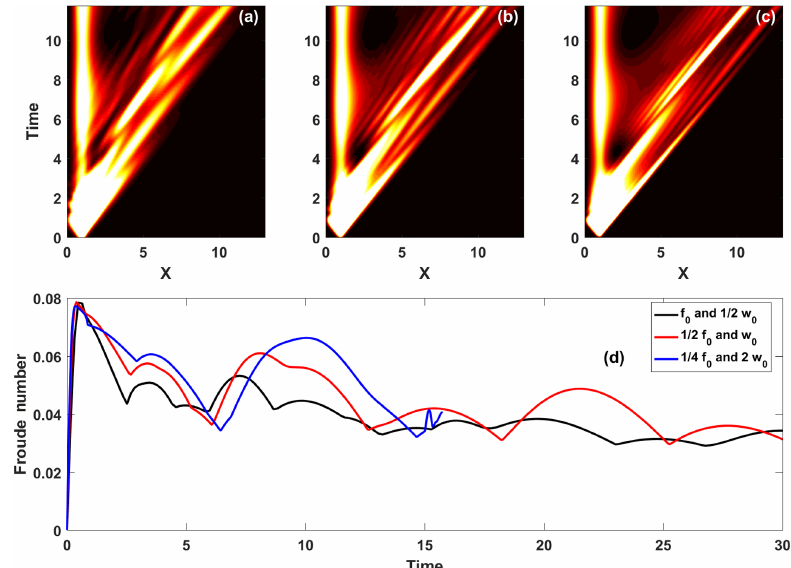
Figure 8. A space–time plot of kinetic energy. The different columns correspond to different combinations of f and w used to form a value w 0 , (b) f = 1 f 0 and w = w 0 , and (c) f = 1 f 0 and w = 2 w 0 . The second row corresponds to the same of Ro = 1. (a) f = f 0 and w = 1 2 2 4 case as the first columns, but the aspect ratio has been scaled by the change in rotation